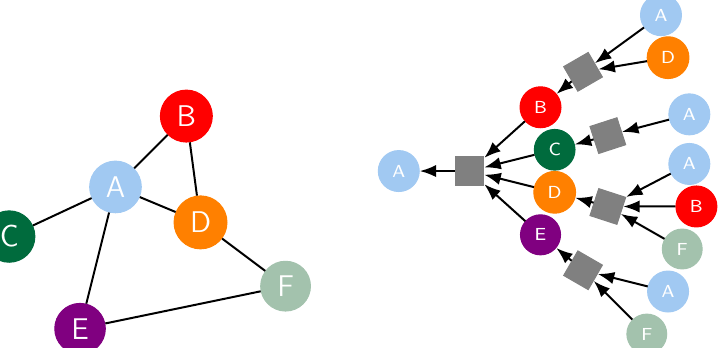
Figure 9. Left: Graph representation. Right: Aggregation of neighbors for node embedding. See text for